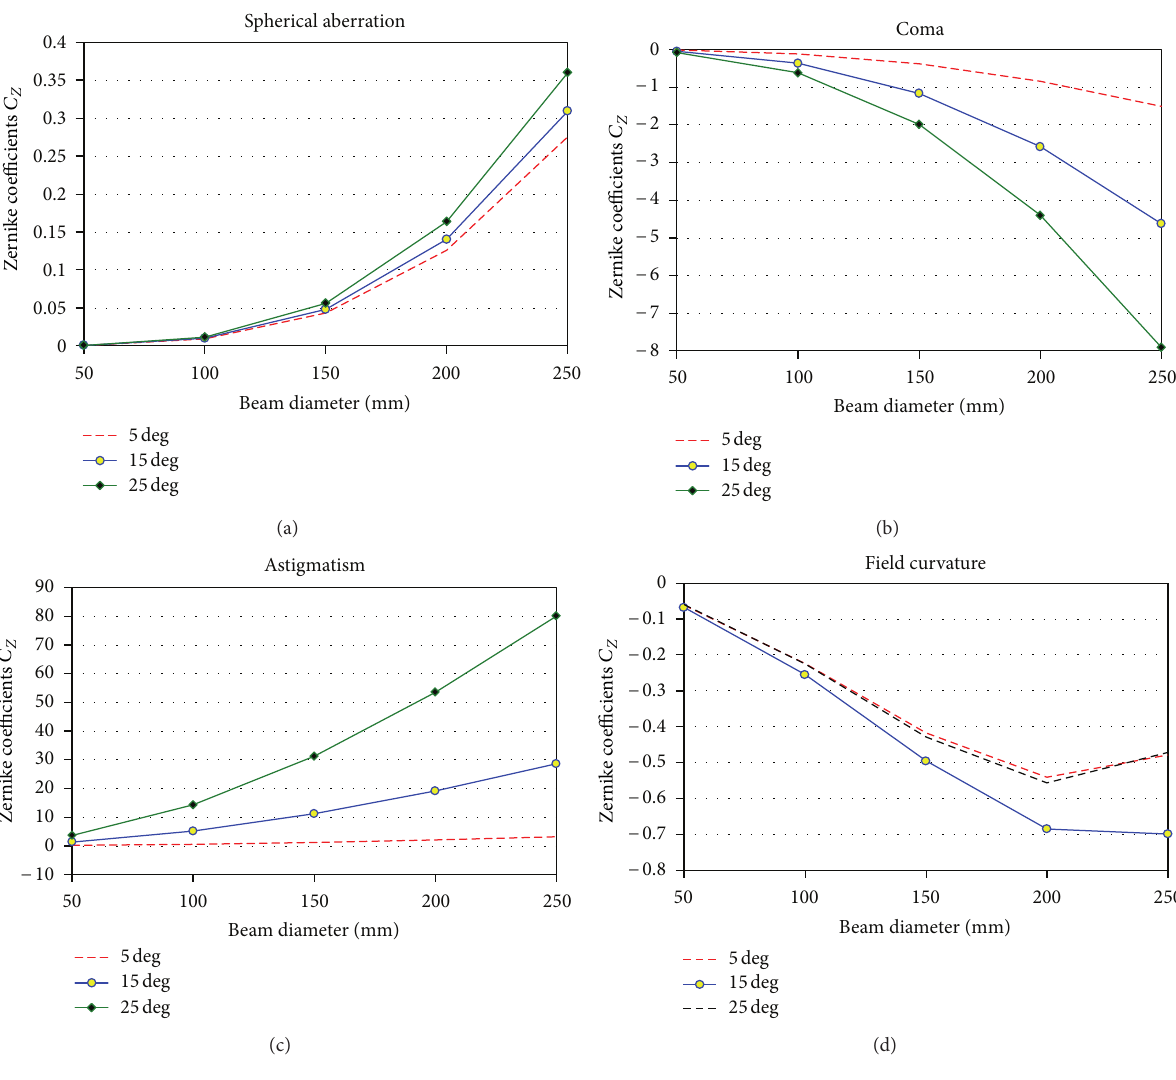
Figure 5: Aberrations as Zernike coefficients for 𝛼 = 5 ∘ − 25 ∘